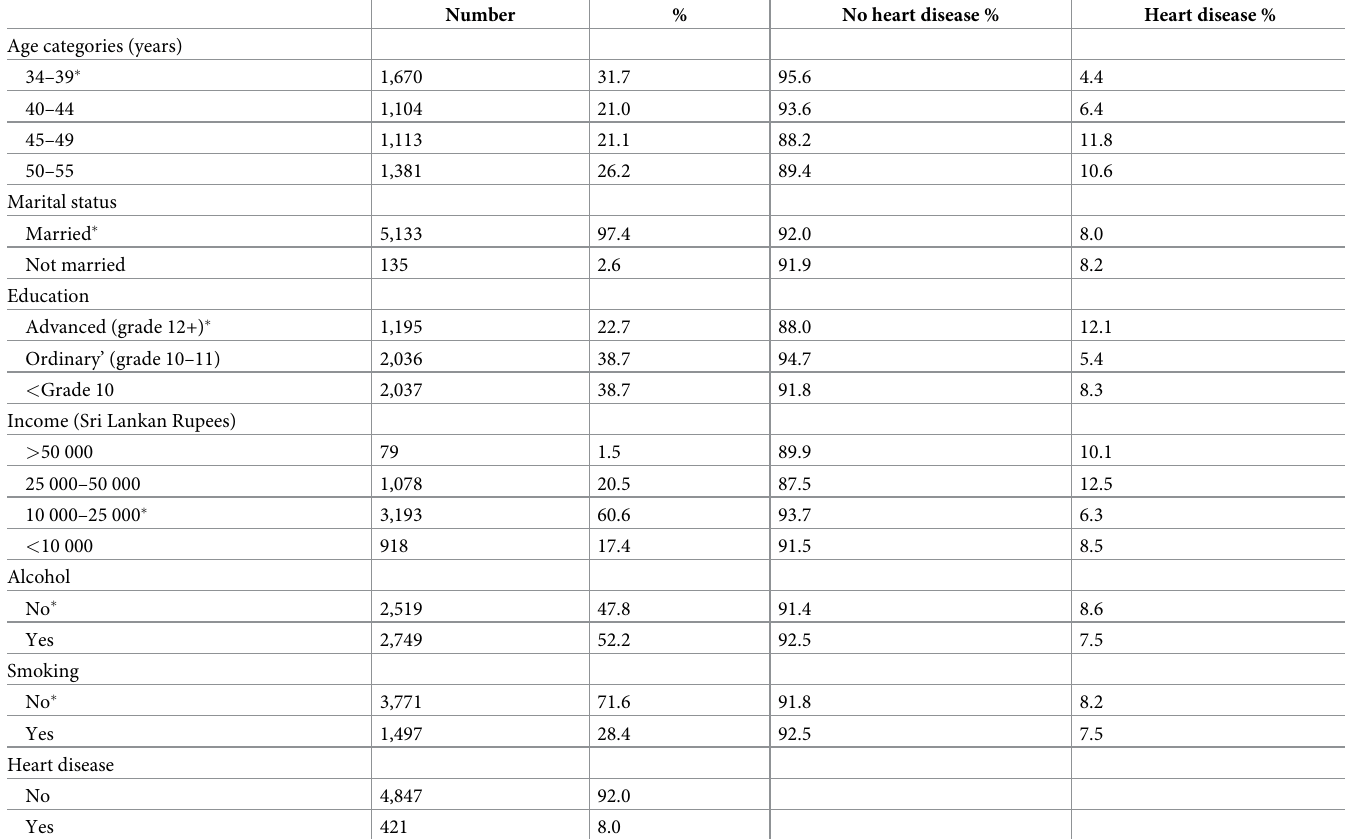
Table 1. Sample characteristics (n = 5,268).